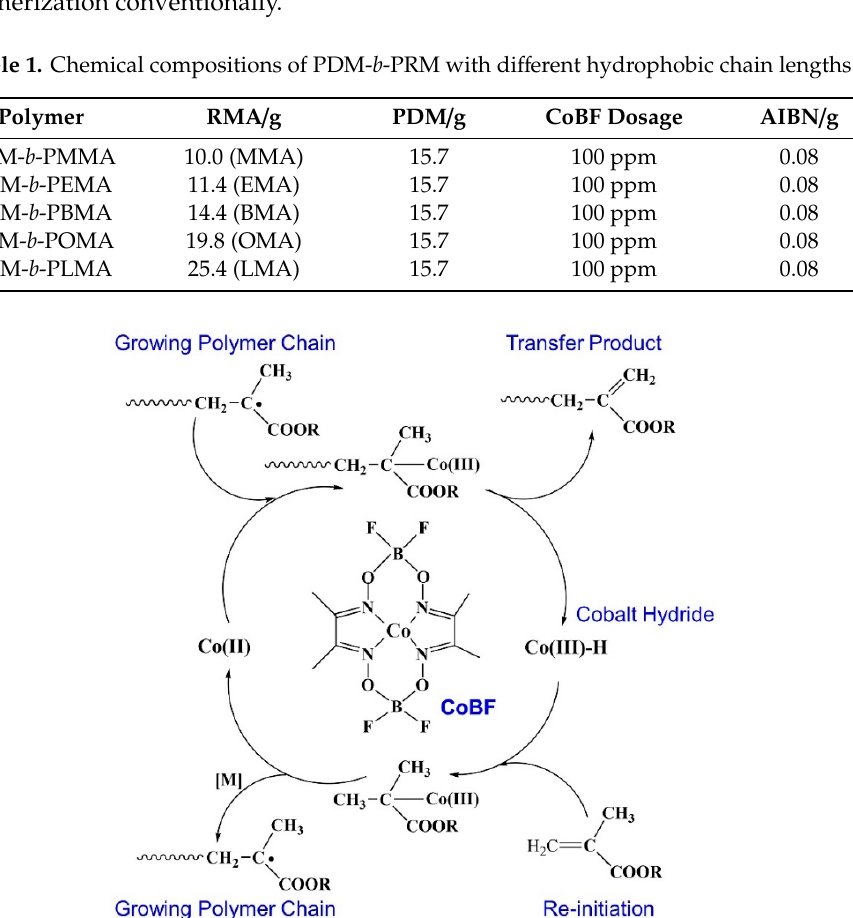
Figure 1. The synthetic process of catalytic chain transfer polymerization (CCTP).